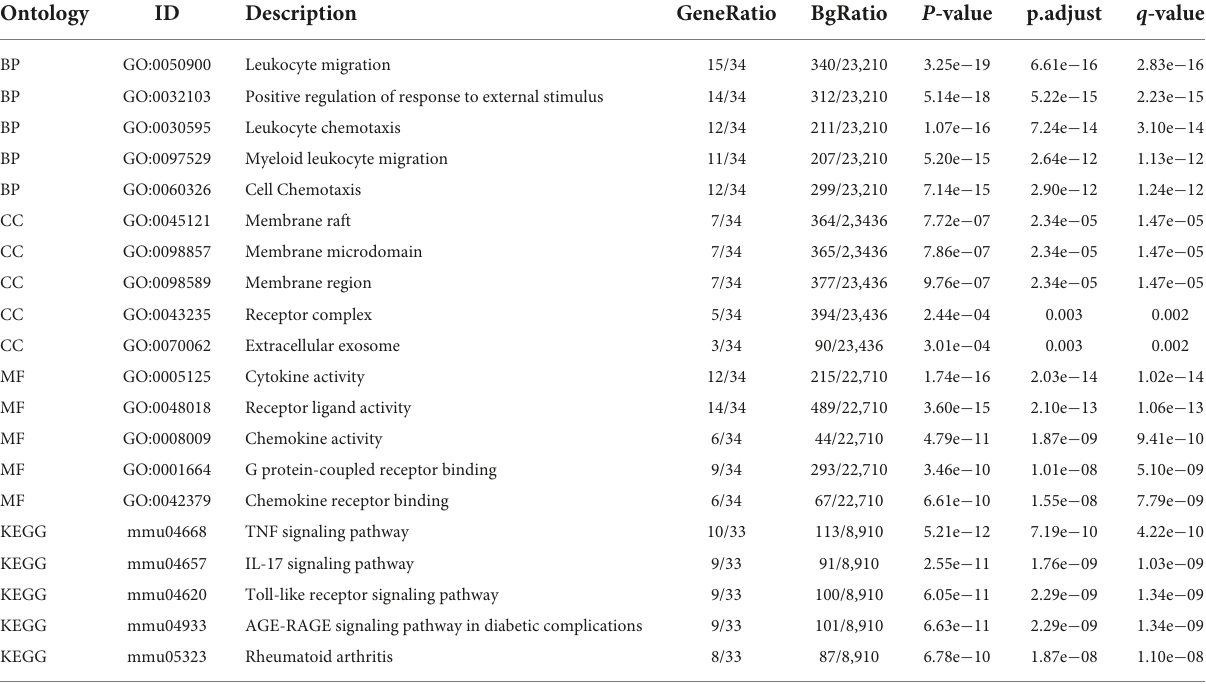
TABLE 2 Enrichment analysis of differentially expressed IRGs in kainite-induced epilepsy. Ontology ID Description GeneRatio BgRatio P -value p.adjust q -value